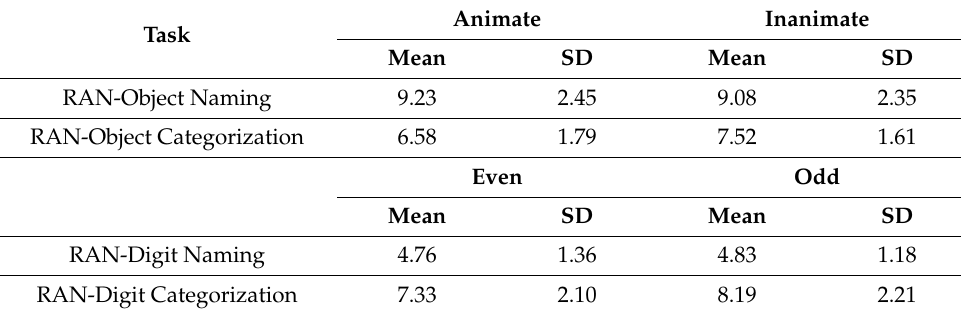
Table 4. Descriptive statistics from two-way repeated measures ANOVA for total fixation duration (measured in seconds) across animacy/digit type and response type.